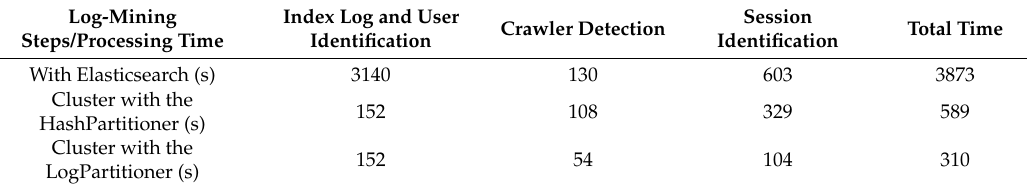
Table 1. Comparison of time cost of each step in the log-mining process.